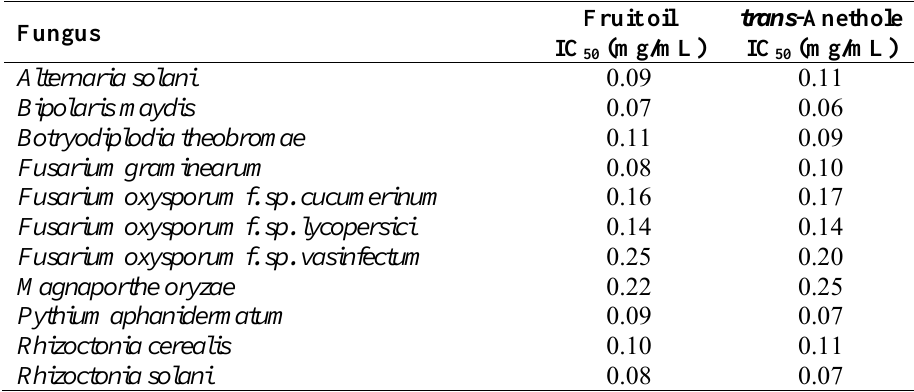
) of I. verum fruit oil and trans -anethole against plant 50